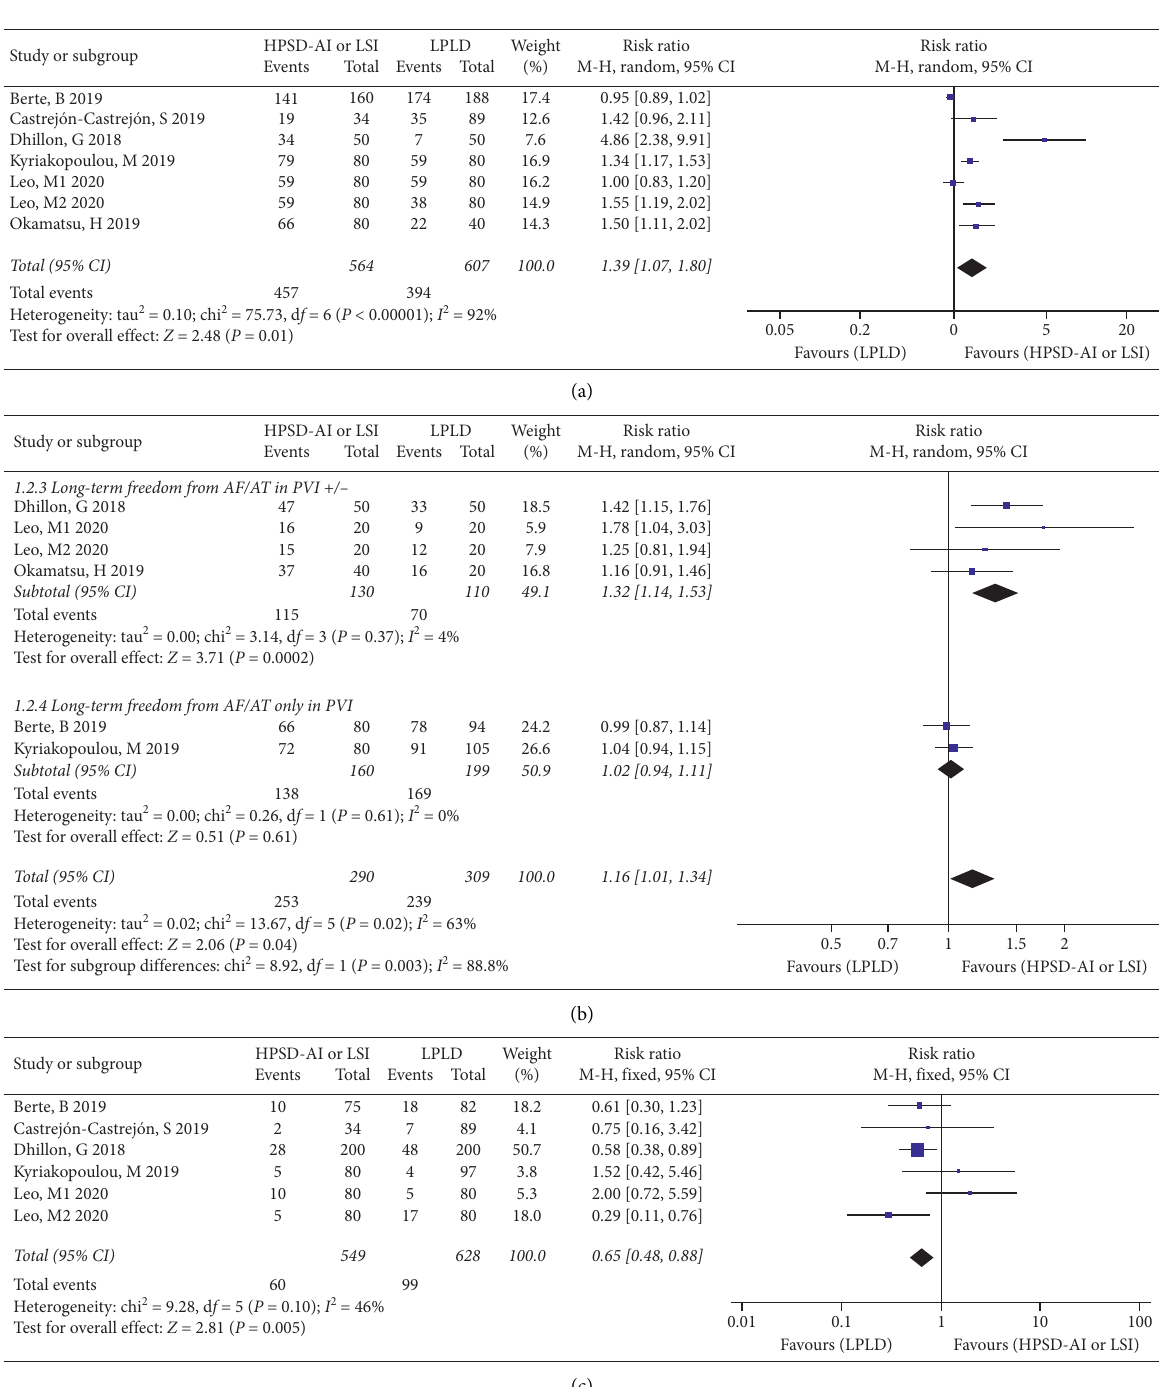
Figure 2: Forest plot displaying the efficacy outcomes in the HPSD-AI or LSI group compared to the LPLD group. (a) First-pass PVI, (b) long-term freedom from AF/AT, and (c) acute